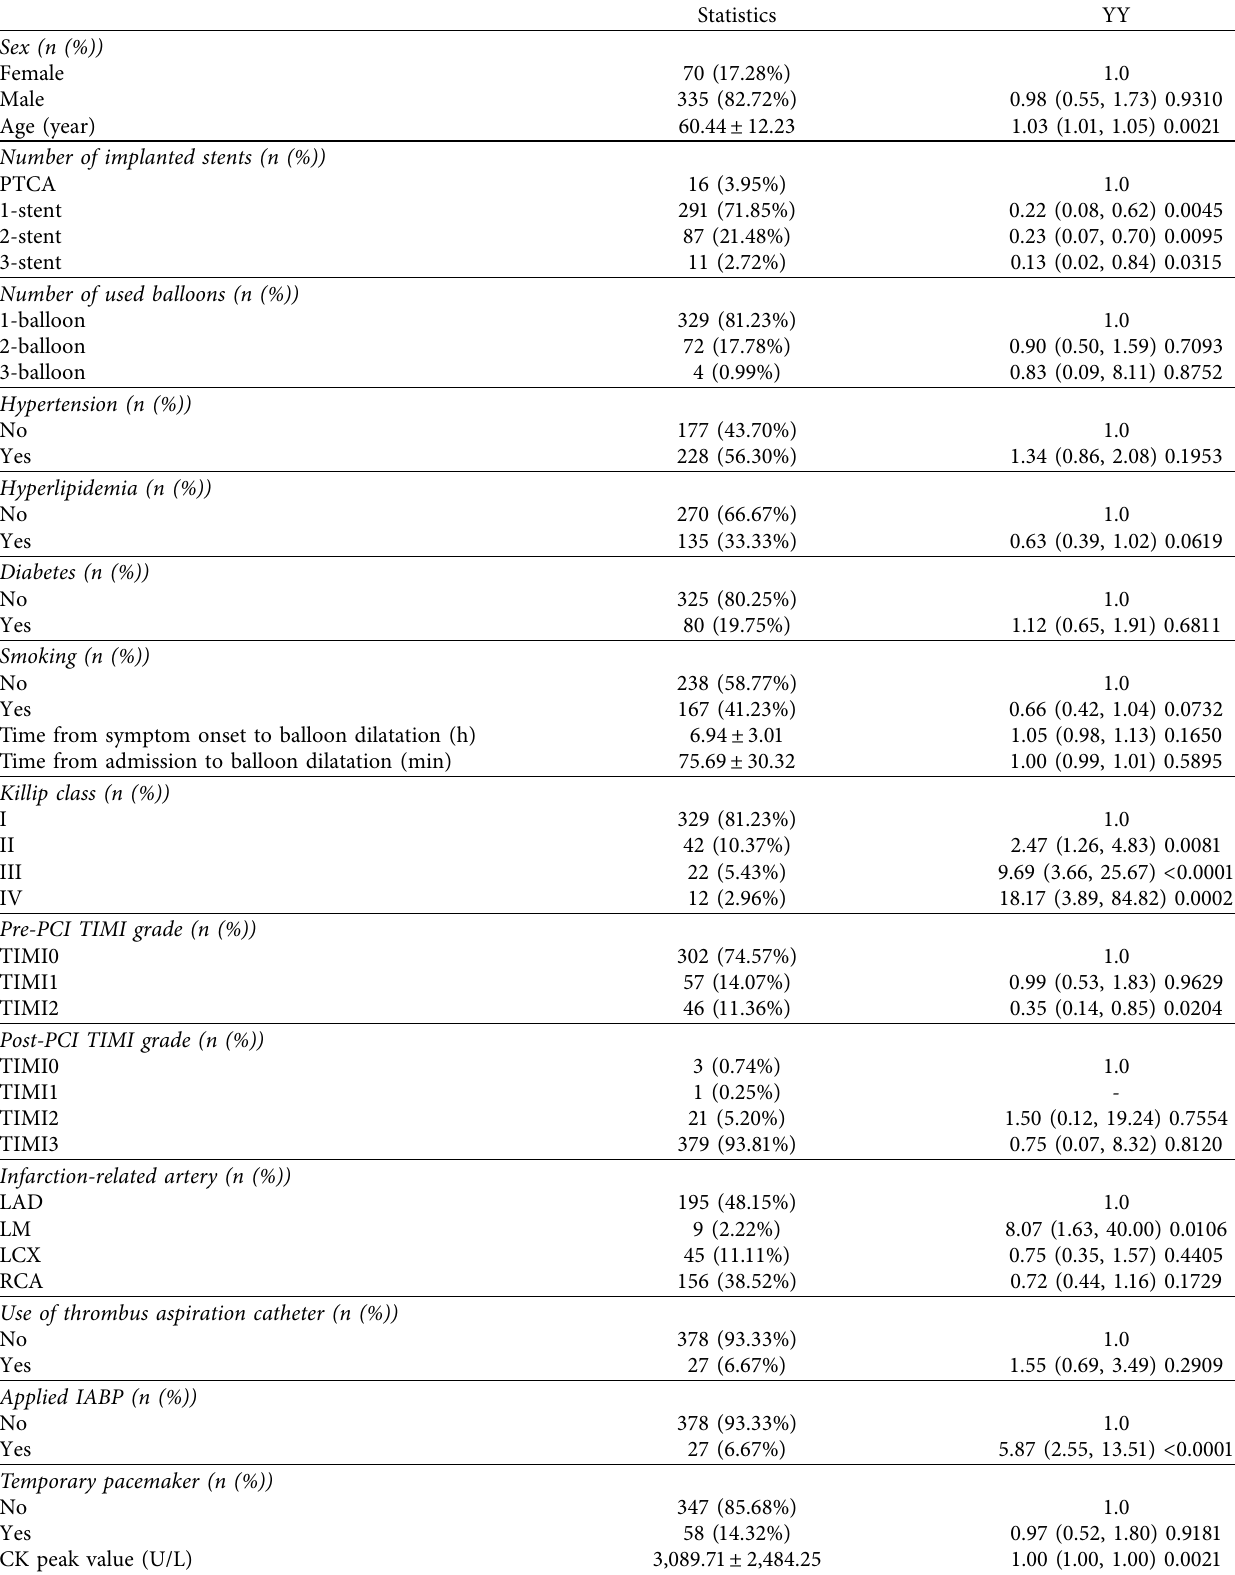
Table 2: MACE of univariate